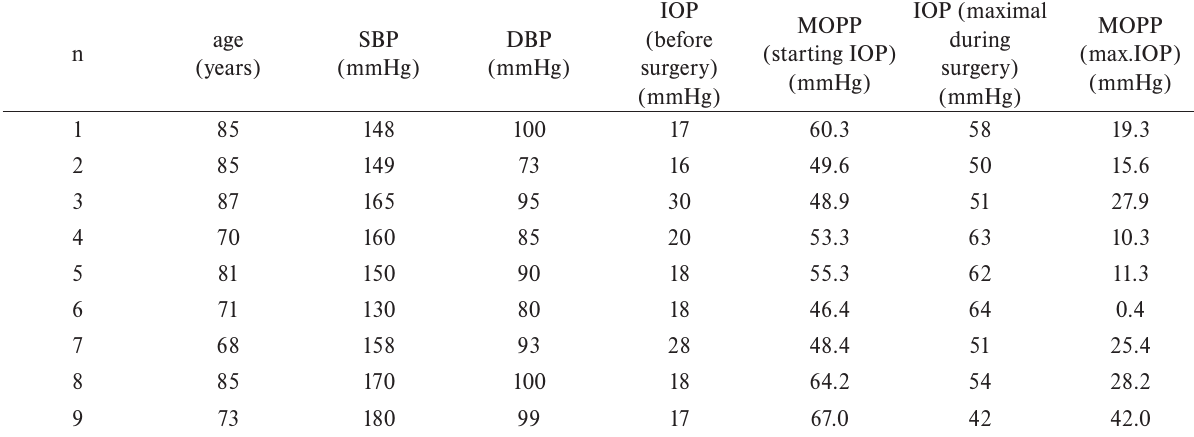
Table 2. Blood pressure values prior to surgery and calculation of eye